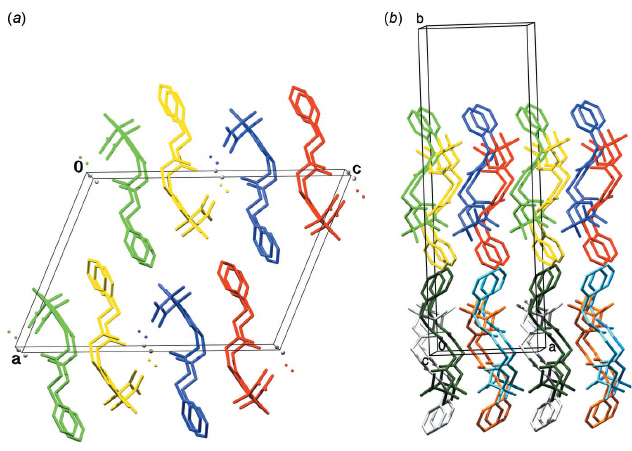
hydrogen bonded in a zigzag manner down the b axis and the blue and red symmetry-related ones in zigzag manner along the b axis. The second intermolecular hydrogen bond is formed between the NH group of Aib and the carbonyl group of Aib of a y -translated (+1 or (cid:2) 1) molecule, shown as pairs of the same color in Fig. 3 a . The same carbonyl group accepts the hydrogen bond from the water molecule. As this water mol- ecule also coordinates the calcium ion, which is bonded to the translated and inverted molecules, multiple bonded molecule layers are formed in the b c plane. These single molecule layers stack together via apolar contacts between the Z protection groups and the Aib side chains, along the a -axis direction (Fig. 4 a ). The shortest distance between two symmetry-related rings is 3.54 A˚ and 3.91 A˚ between the Aib side chain and a symmetry-related ring. The staggering angles between the Z rings of successive sheets are 119.9 (cid:5) while the distance between the centre of the rings is 4.79 A˚ . Finally, in one layer the rings of the Z protection groups are staggered parallel with a distance of 5.57 A˚ , which is equal to the length of the b axis. In the crystal structure of II , one molecule (the left green molecule in Fig. 3 b ) is hydrogen bonded to four other mol- ecules. The carbonyl group of Z and the C-terminal OH group of Aib are hydrogen bonded to the same molecule (Fig. 3 b ) and to the left green molecule. The NH group of Gly is hydrogen bonded to the carbonyl group of Gly1 of the right